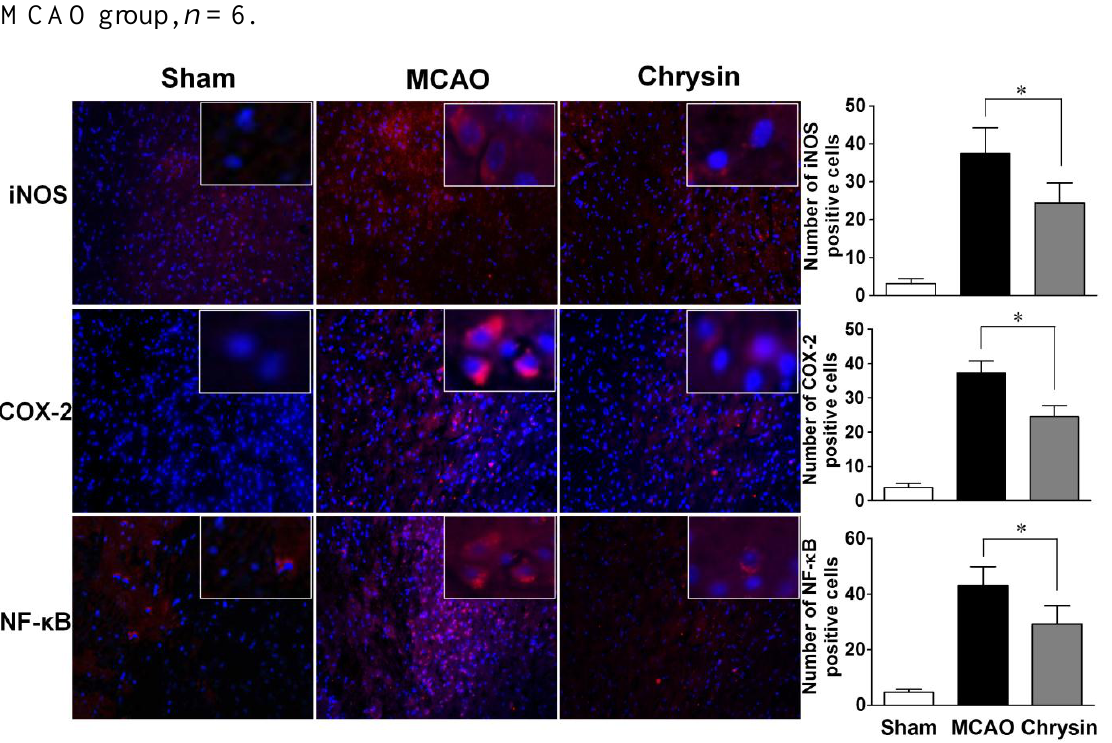
suggest that the anti-inflammatory activity of chrysin is mediated by inhibiting NF-κB activation and